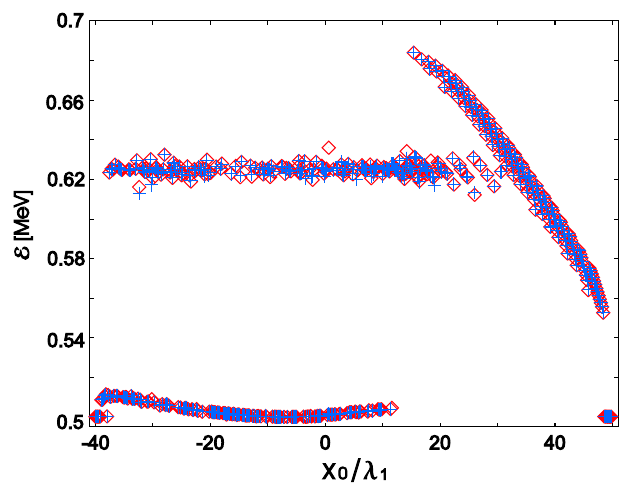
FIG. 6. The same dependence as in Fig. 5 for ! 1 =! 2 ¼ 2 ; other parameters are defined in the text for Figs. 1 and